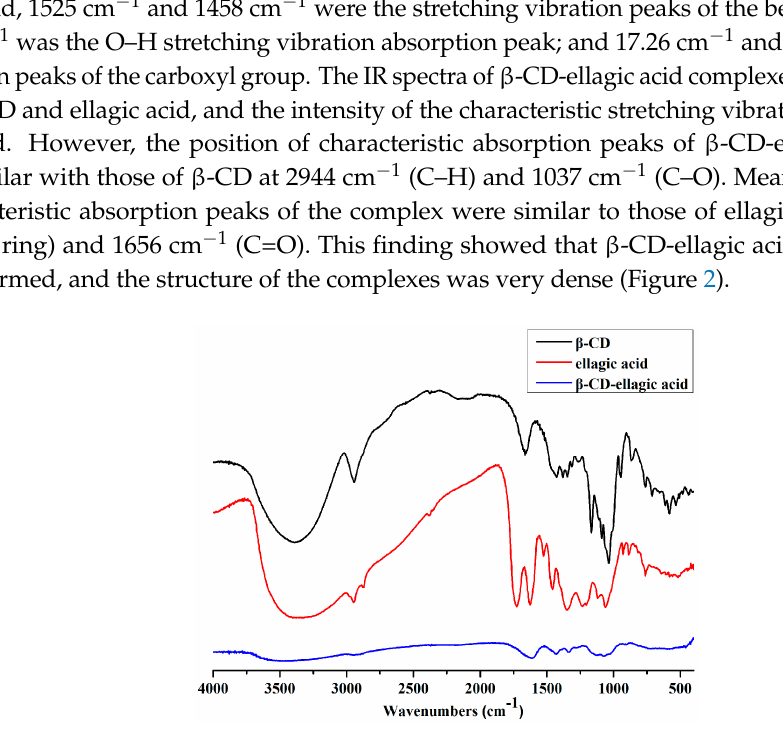
Figure 2. Infrared (IR) spectrum of β -CD-ellagic acid microspheres.